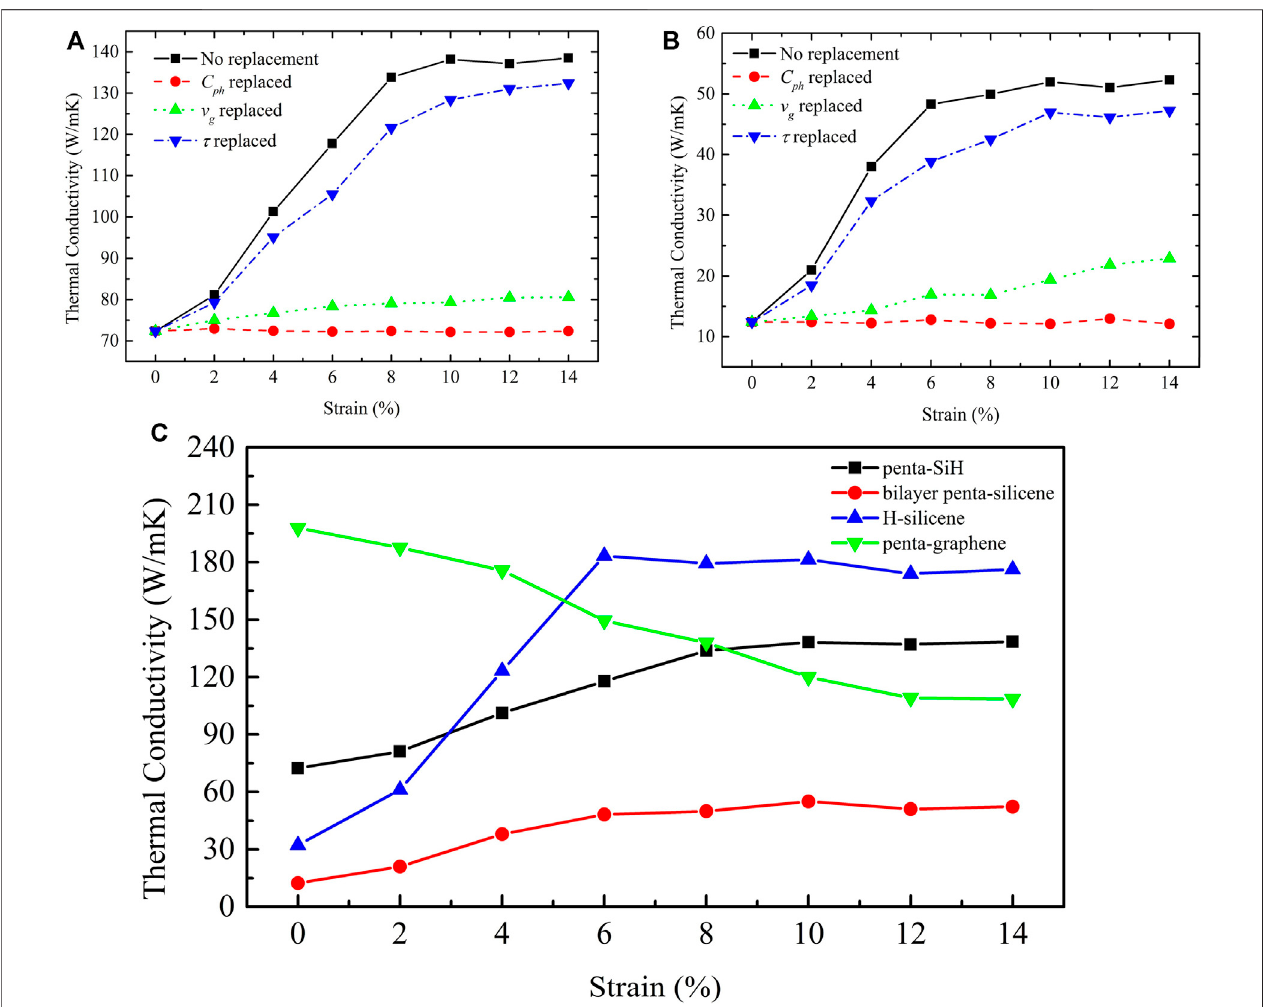
FIGURE2| Intrinsiclatticethermalconductivityofpenta-SiH (A) andbilayerpenta-Si (B) . “ Replaced ” meansthatthecorrespondingtermwasreplacedbythevalue atcertainstrainsandtheothertermstayedwithnon-strainvalues. (C) Comparisonofthestrain-dependentintrinsiclatticethermalconductivityamongpenta-SiH,bilayer penta-Si, H-silicene, and